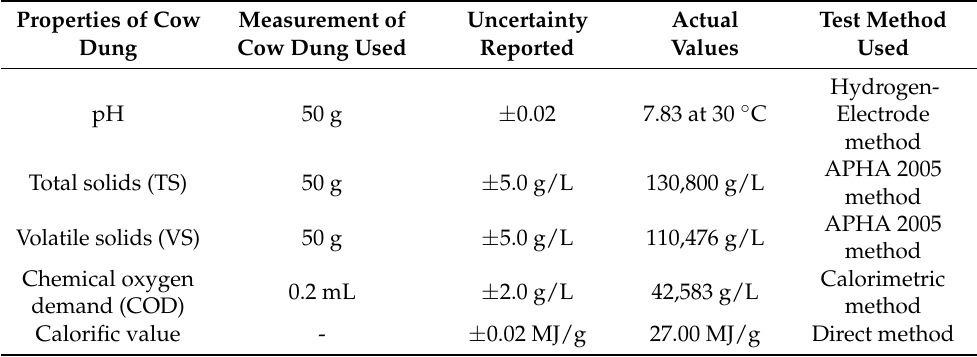
Table 3. Properties of fresh cow dung used in the study [28].